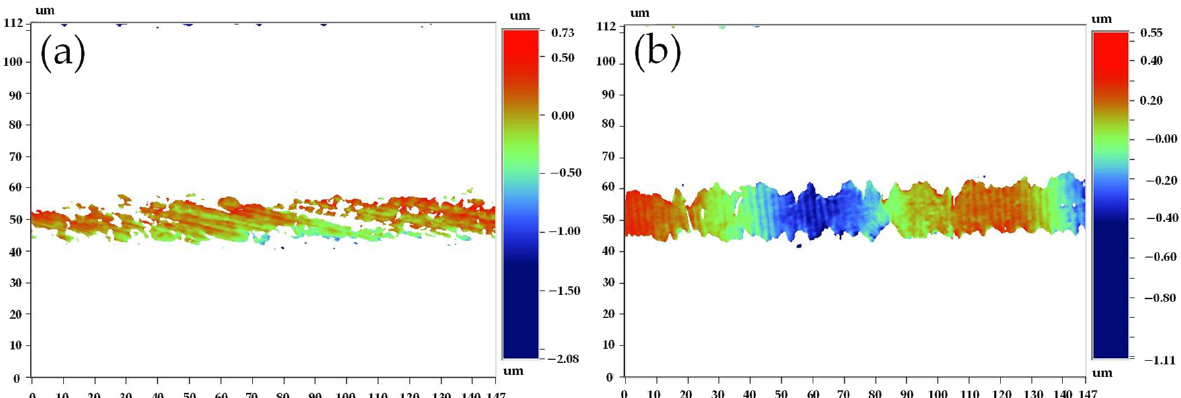
Figure 3. Spectral distribution of the ( a ) longitudinal texture and ( b ) transverse texture roughness obtained by optical profilometer measurements. The side-wall profile of sensitive grid can also be observed in ( b ).